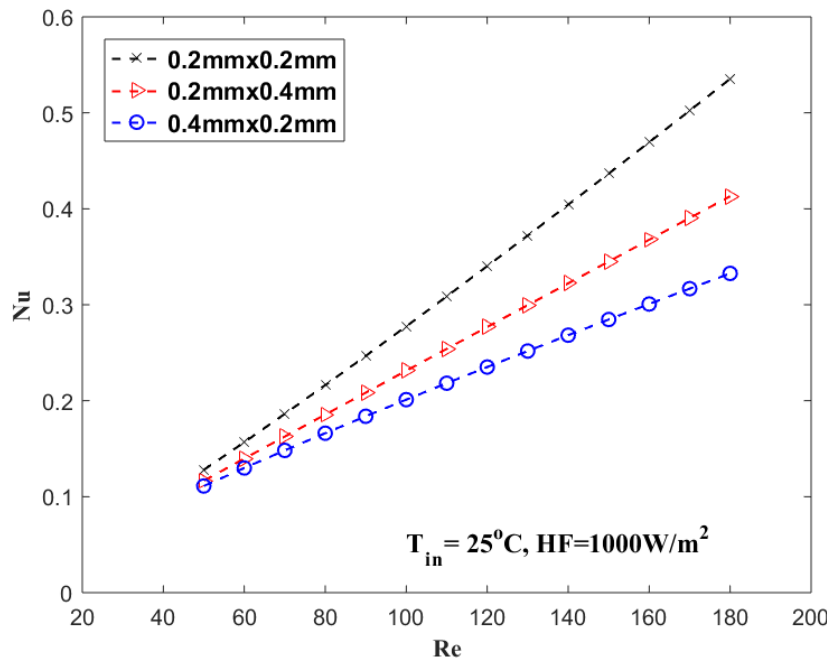
Figure 11. The calculated Nusselt number at various Reynolds numbers.